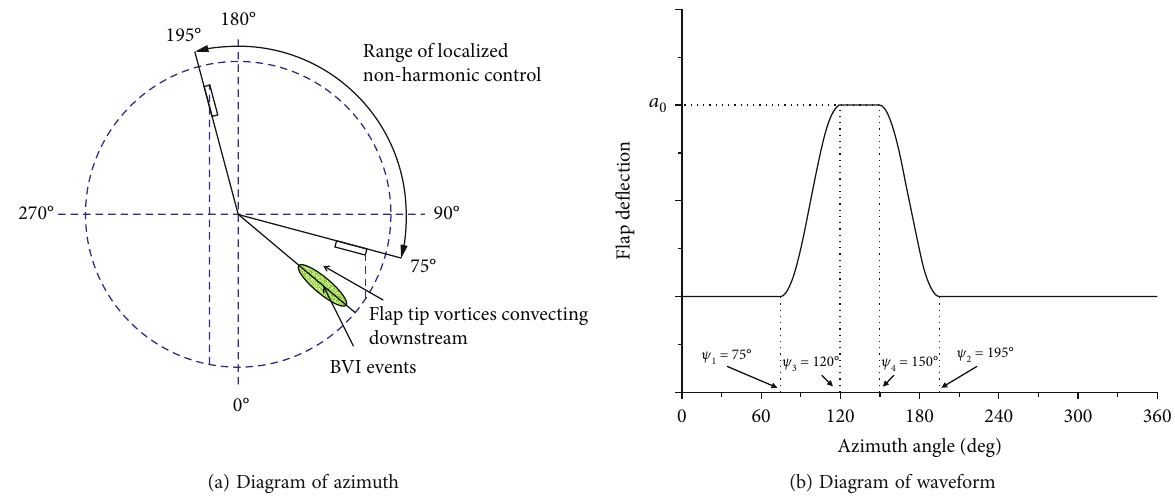
Figure 3: Schematic diagram of the azimuth and waveform of the oblique square wave input in the second quadrant of fl ap.